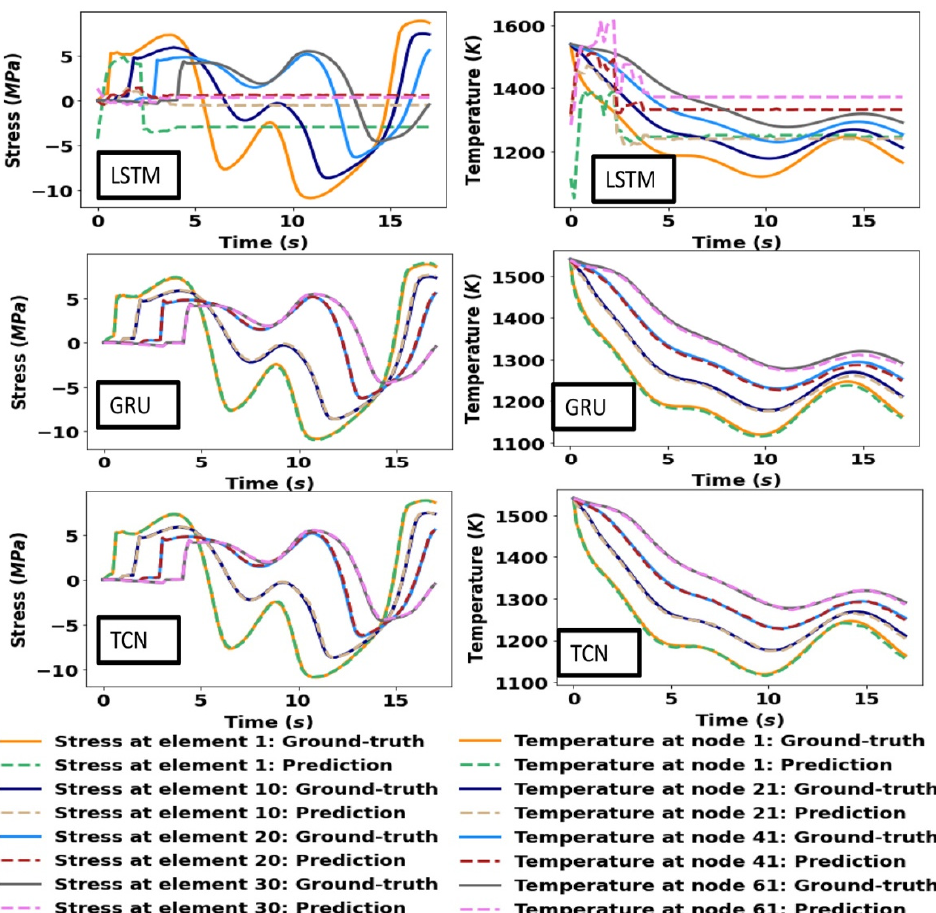
Figure 10. Output results, ground-truth, and deep learning predictions for the 4 control points, corresponding to the testing input sample in Figure 7.